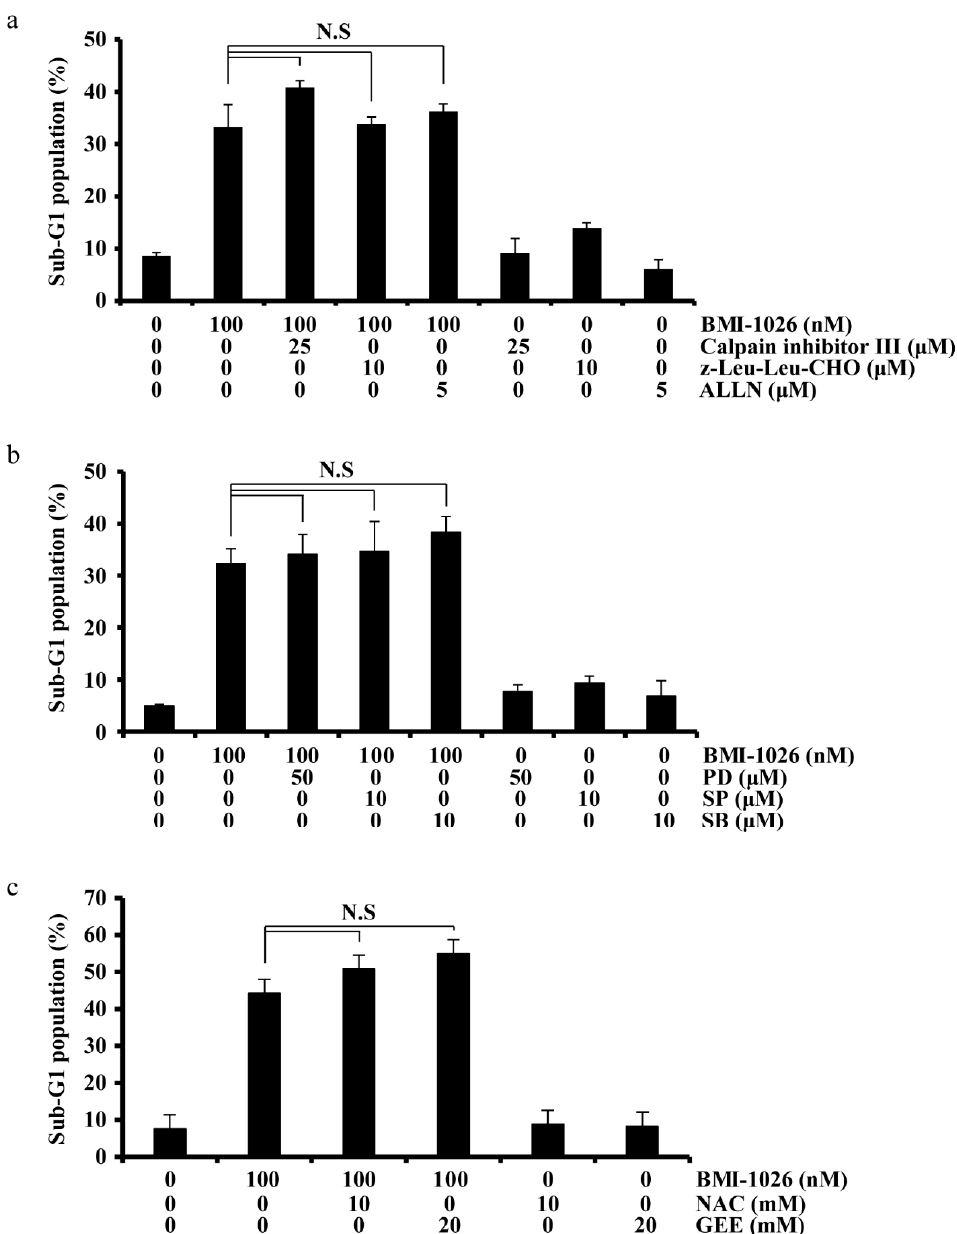
Figure 5. Involvement of various apoptosis-related pathways, including the calpain, mitogen-activated protein kinase, and reactive oxygen species signaling pathways. ( a – c ) Caki cells were treated with the indicated drugs for 30 min, followed by addition of 100 nM BMI-1026 for 24 h. Apoptosis was analyzed by flow cytometry ( a – c ). Values in the graphs ( a – c ) represent the mean ± SD of three independent experiments. N.S, no significance.